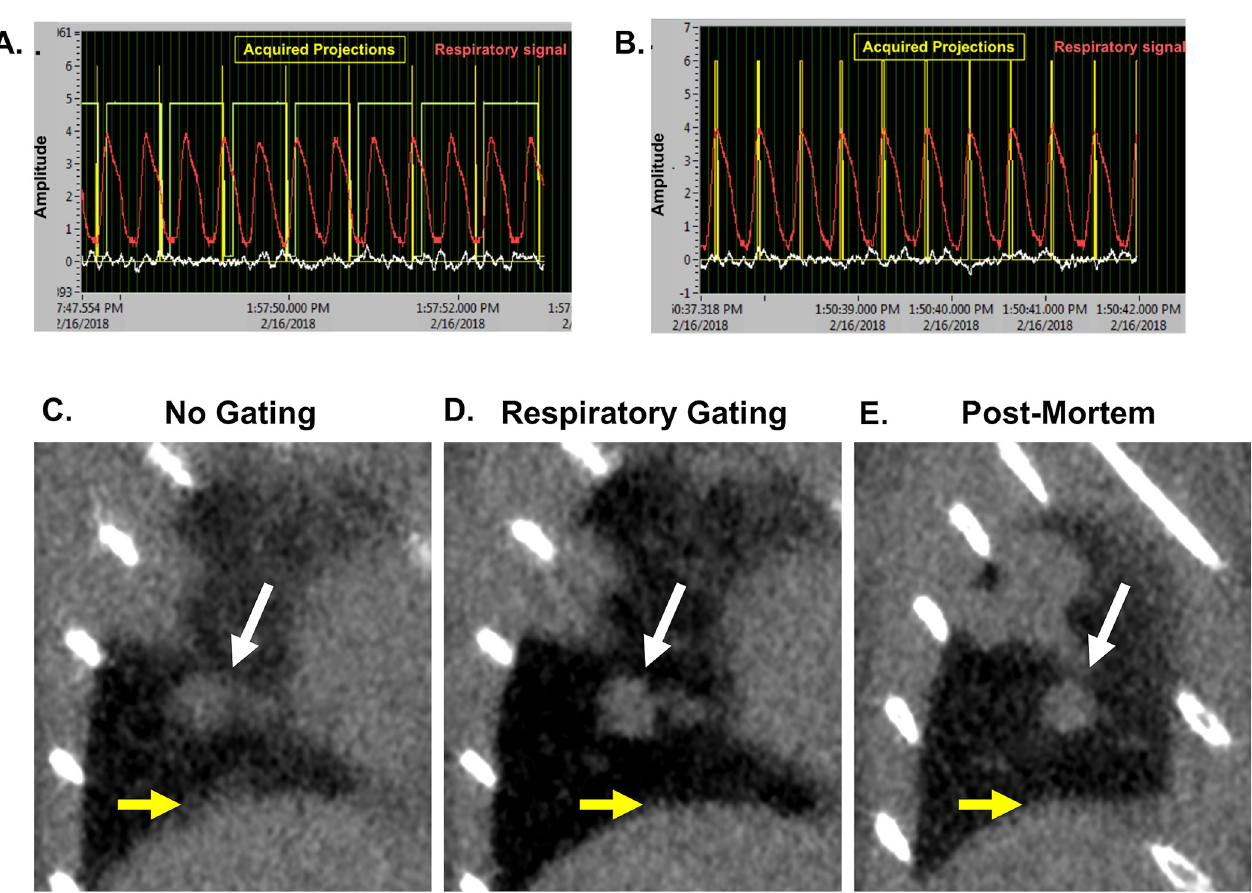
Fig 8. Prospective gating allows for synchronization of image acquisition with breathing patterns. Micro-CT acquisition monitoring without (A) and with respiratory gating (B). Coronal images of a lung tumor are shown without gating (C), with respiratory gating (D), and post-mortem (E). Tumor is indicated by white arrows, and diaphragm is noted with yellow arrows. Representative images from triplicates are